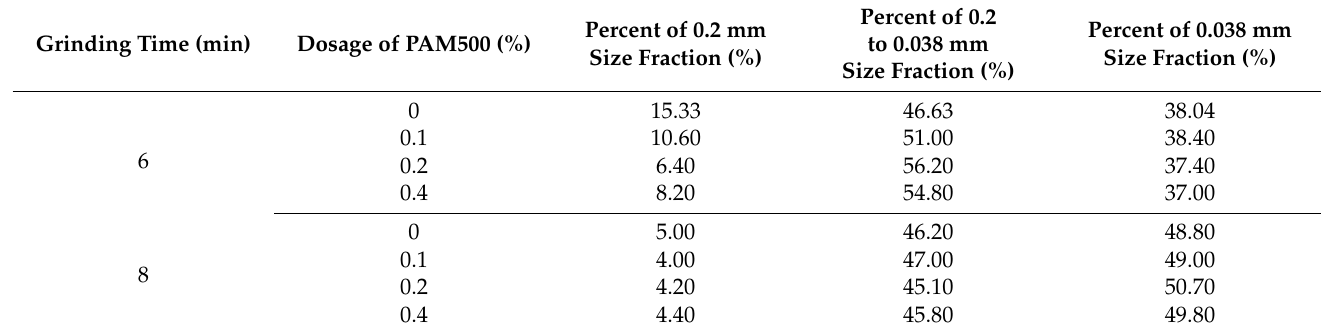
Table 3. The relationship between the product size fractions and the dosage of PAM500 using different grinding